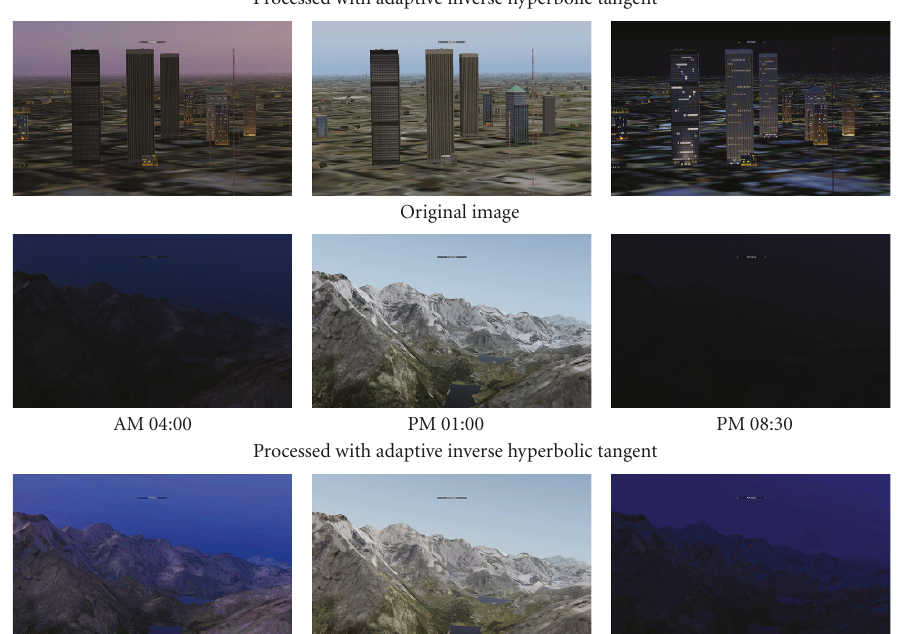
in Figure 11(b). Decreasing the gain( x ) value increases the contrast of the remapped image. Shifting the distribution toward lower levels of light (i.e., decreasing bias( x )) decreases the highlights. By adjusting the bias( x ) and gain( x ), it is possible to tailor a remapping function with appropriate amounts of image contrast enhancement, highlights, and shadow lightness as shown in Figure